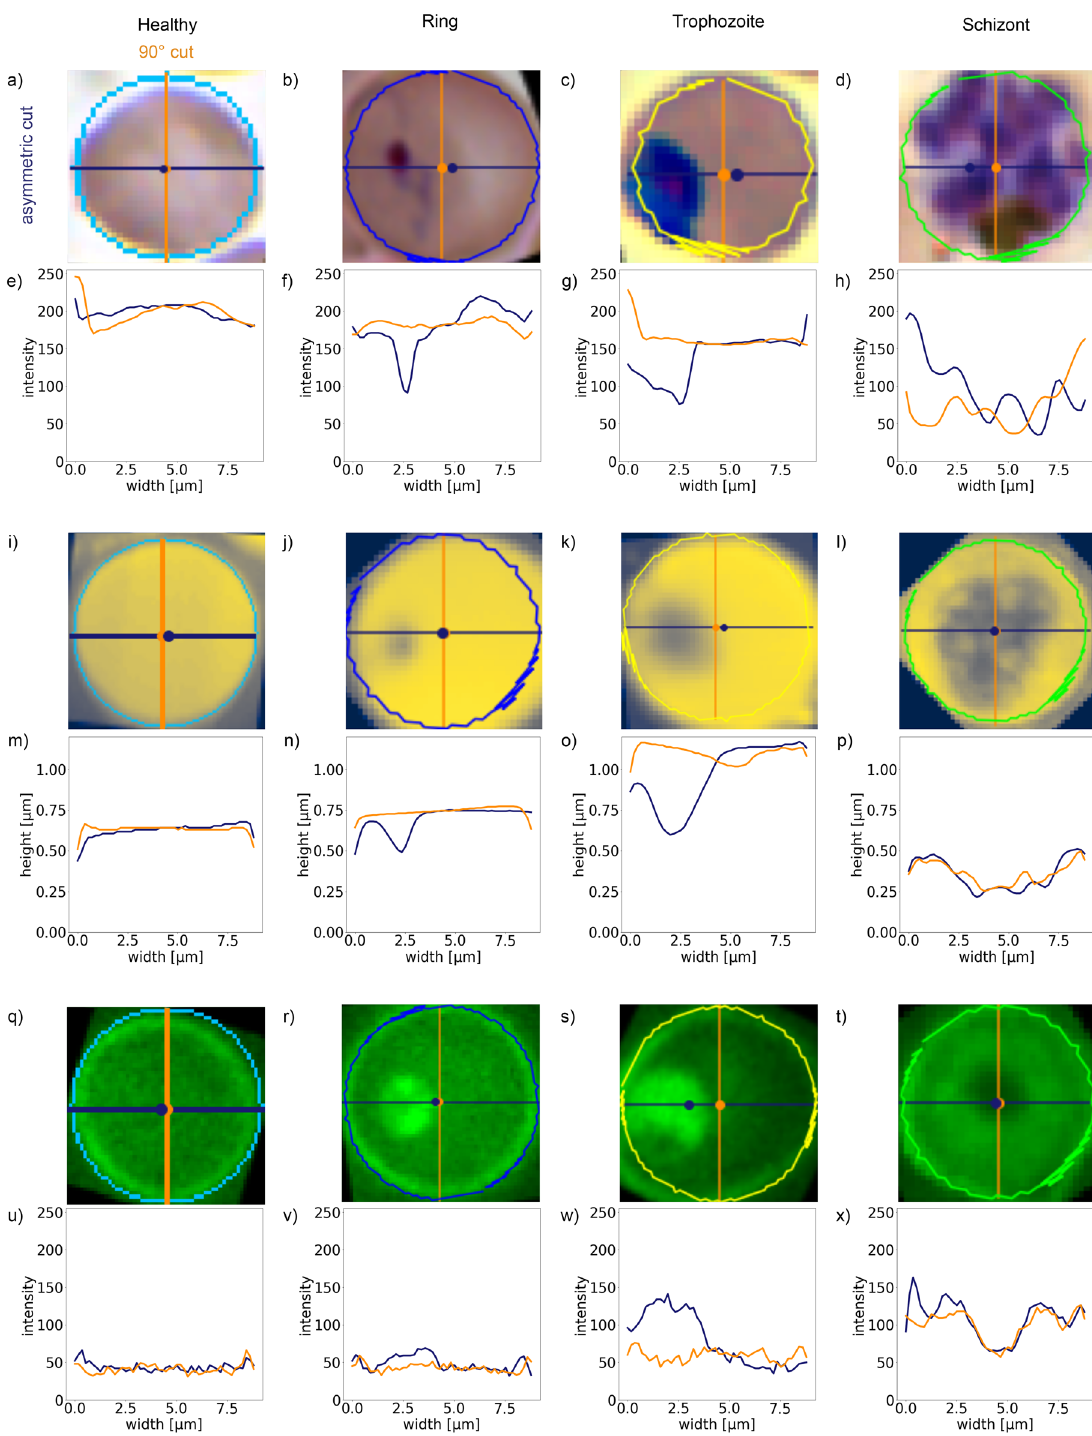
Figure 5. Characteristic cross-sections through single-RBC images. Similar to Fig. 2, columns show the four different categories (healthy RBC and RBCs infected by ring, trophozoite and schizont stages), while rows correspond to different imaging methods. ( a – d ) Light microscopy images of Giemsa-stained RBCs. The coloured circles surrounding the detected cells are the determined cell contours (see also Fig. 3). The geometric centre and the centre of mass are marked by an orange and a blue dot, respectively. The asymmetric ◦ cut connecting the two centres and the 90 cut only crossing the geometrical centre are indicated by a blue and ◦ an orange line, respectively. ( e – h ) Intensity profile for the asymmetric (blue) and the 90 (orange) cuts in the images above. ( i – l ) AFM images of RBCs and ( m – p ) their corresponding height profiles along the two cuts. ( q – t ) Fluorescence images of RBCs and ( u – x ) their corresponding intensity profiles along the two